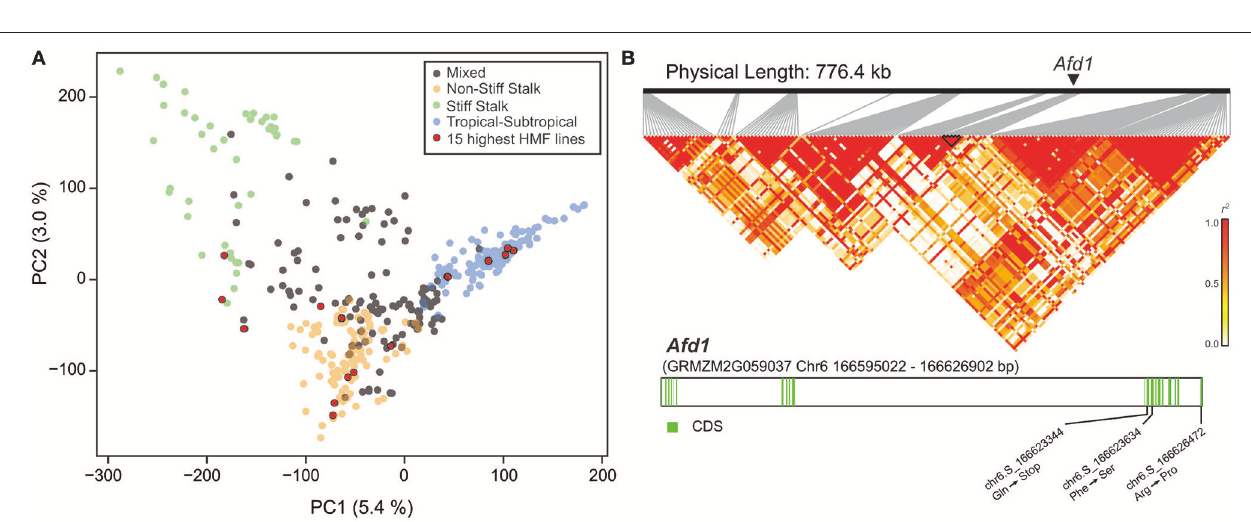
FIGURE 1 | Histograms of the BLUEs for haploid male fertility (HMF) for each genetic background separately (“Mo17” and “Zheng58”) and across both genetic backgrounds, and correlation between the HMF BLUEs of the 481 genotypes in the two genetic backgrounds.